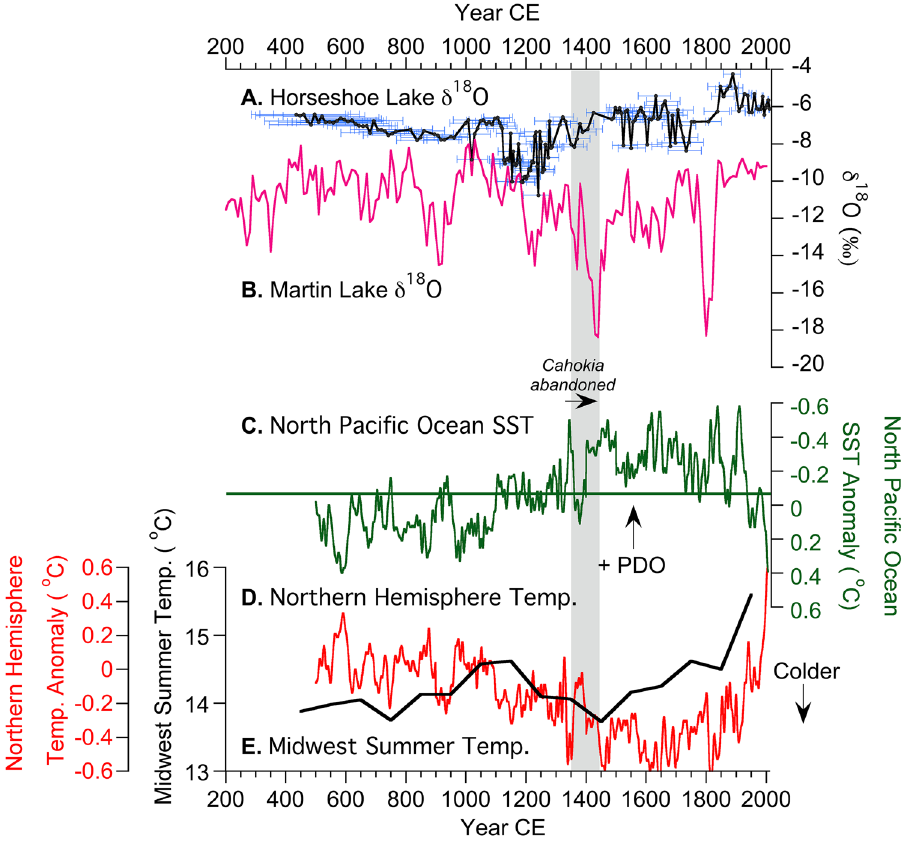
Figure 2. Proxy records for the last 1600 years. ( A ) Horseshoe Lake calcite δ 18 O data with 95% confidence intervals (this study). ( B ) Martin Lake calcite δ 18 O data 13 . ( C ) North Pacific Ocean sea surface temperature (SST) reconstruction. Negative SST anomalies indicate positive Pacific Decadal Oscillation (PDO) conditions 15 . ( D ) Northern hemisphere temperature anomalies 15 compared against the ( E ) pollen-based Midwest summer temperature reconstruction from Viau, et al. 28